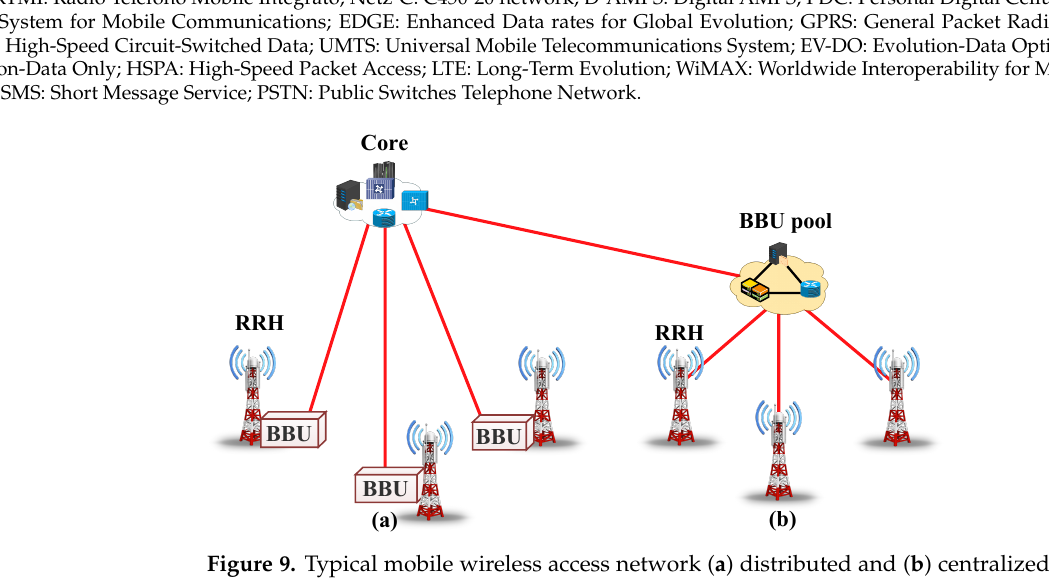
Figure 9. Typical mobile wireless access network ( a ) distributed and ( b ) centralized